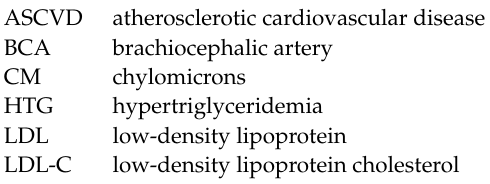
Figure S6: Apoptosis of circulating monocytes in Ldlr − / − mice with P407 injection; Figure S7: Labeling of CD11c+ monocytes by injecting fluorescent microbeads in Ldlr − / − mice with P407 or saline administration; Figure S8: CD11c mRNA in the liver of Ldlr − / − mice with P407 or saline administration; Major Resources Table